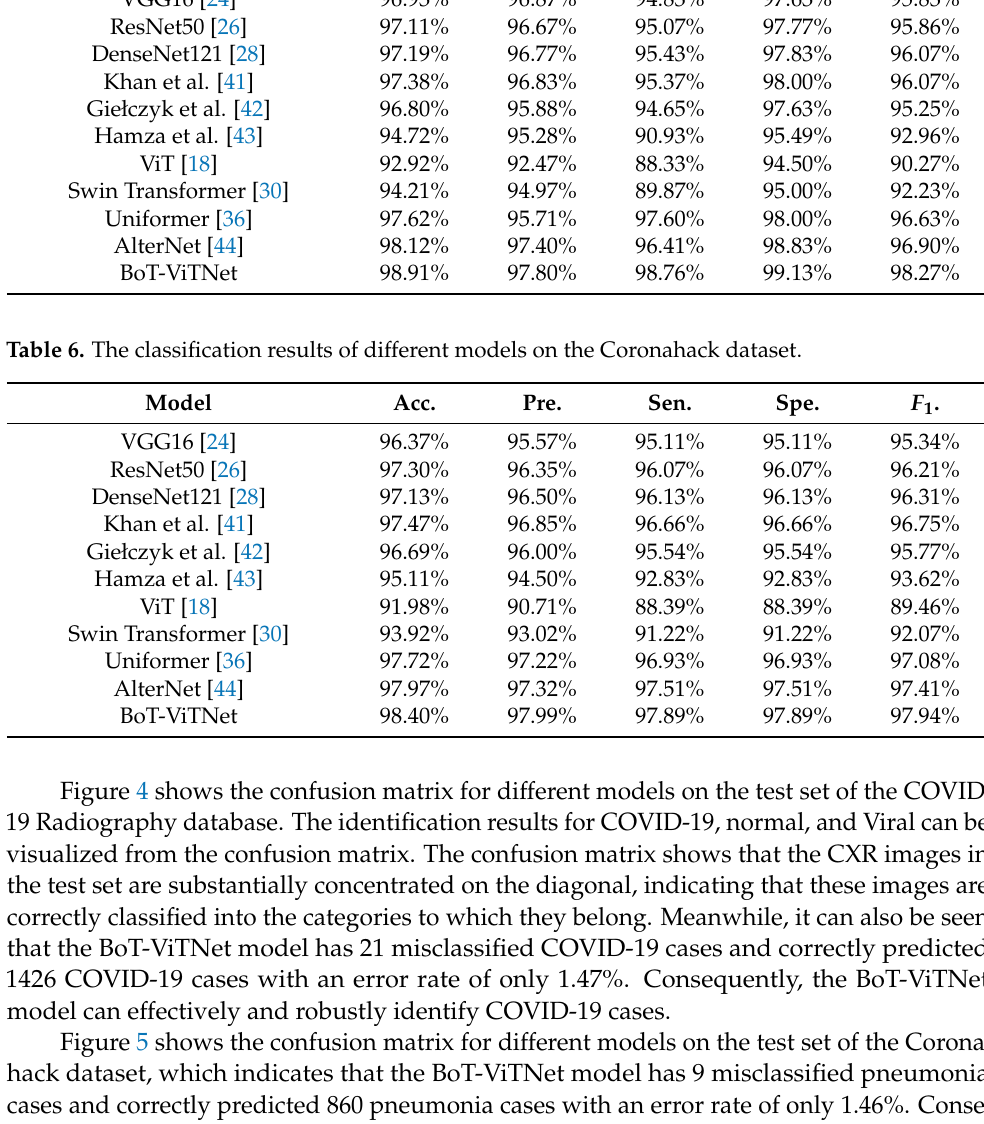
Table 5. The classification results of different models on the COVID-19 Radiography database. Model Acc. Pre. Sen.